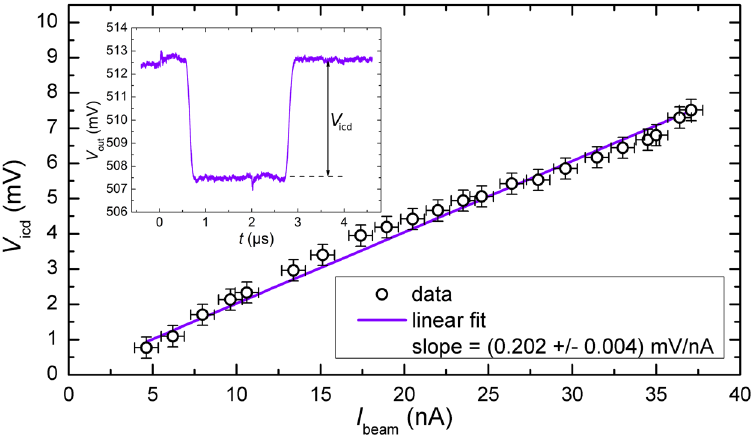
Figure 3. Linear ion beam current calibration curve for a single 8 mm signal electrode (ICD2.1). The inset shows a typical pulse waveform for t pulse > t E with V icd determined as the signal pulse